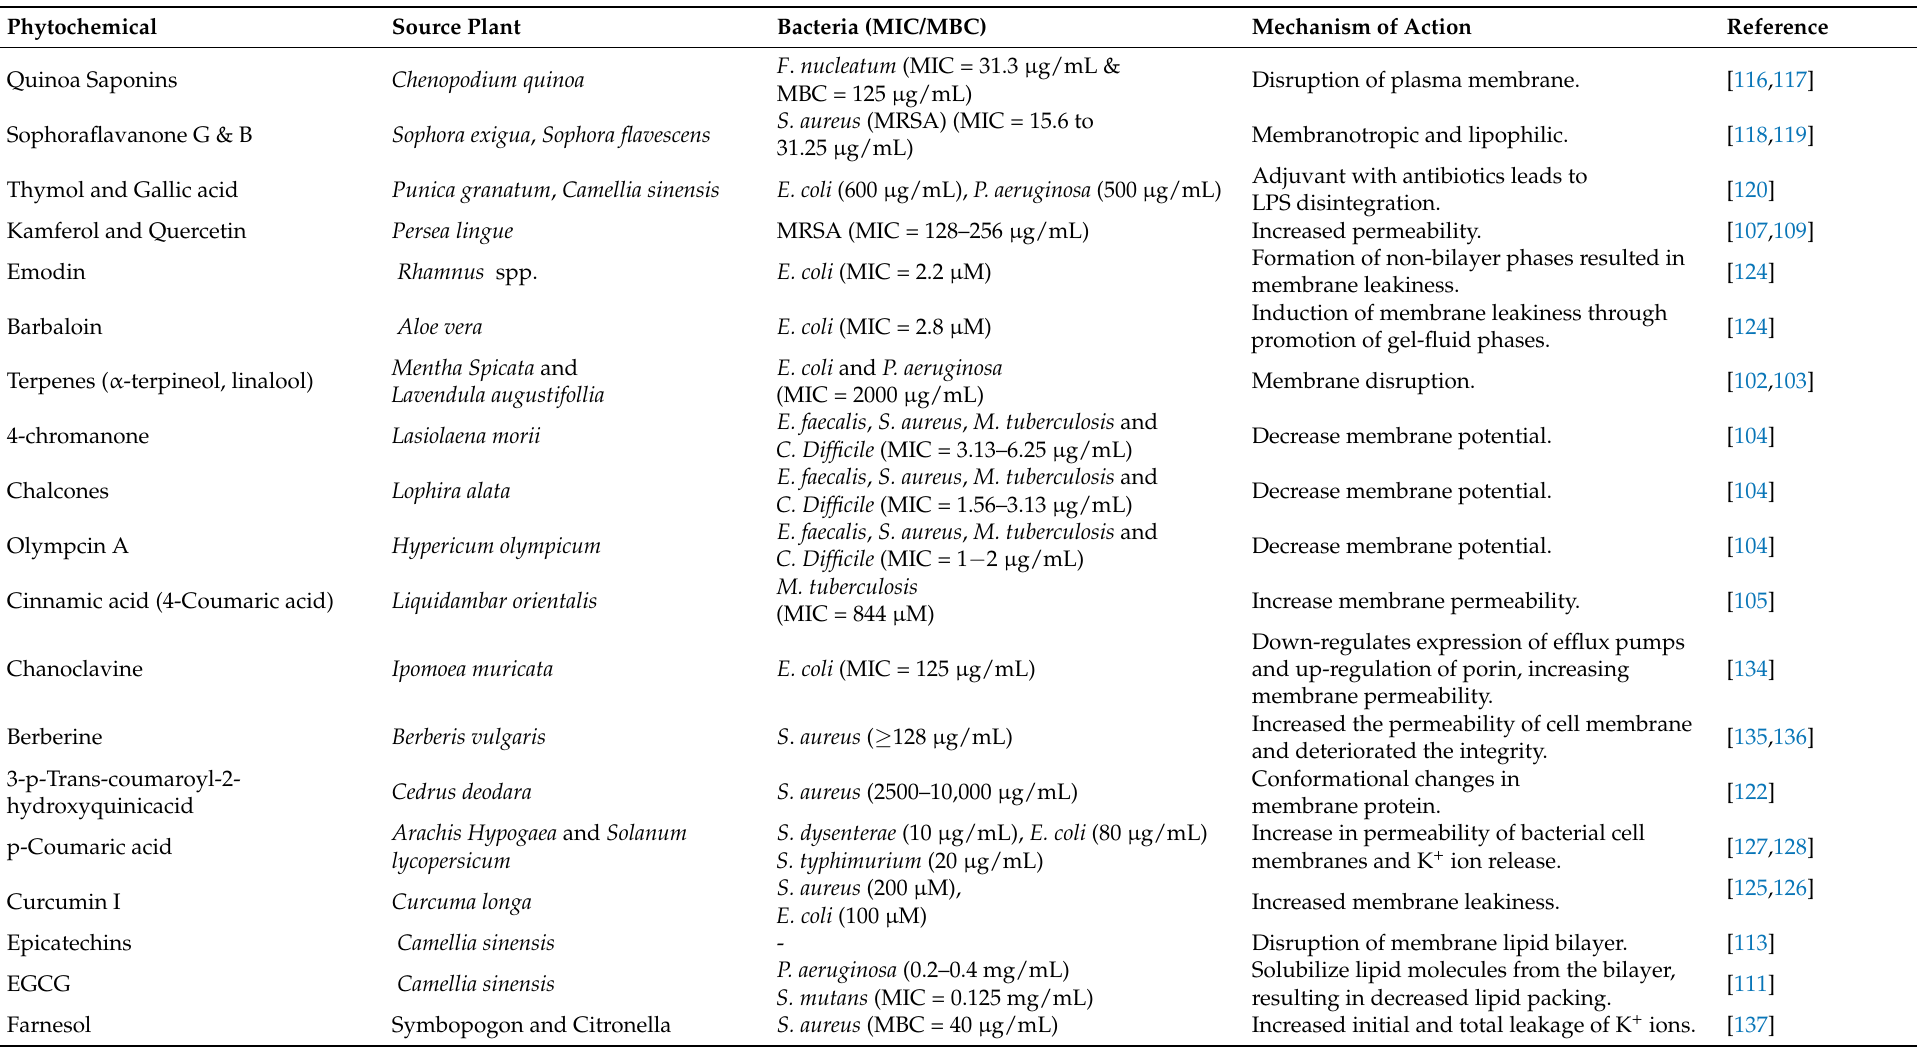
Table 1. Membrantropic phytochemicals that exhibit antibacterial activity through alteration of plasma membrane